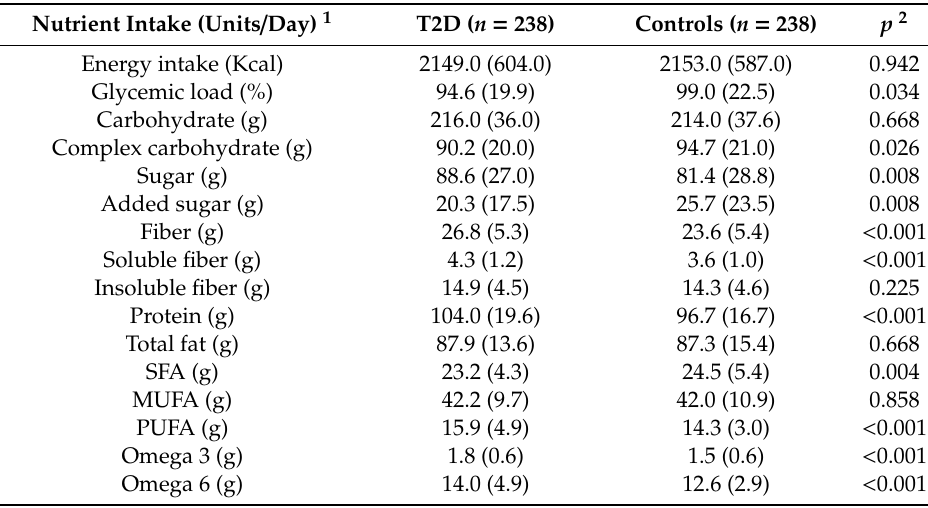
Table A2. Daily nutrient intake of the study